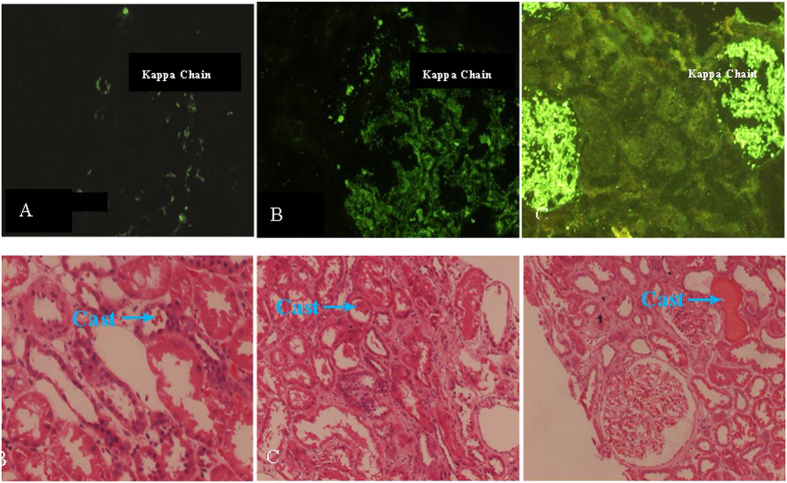
Histopathological findings in MM-RI patients (40×).(A) Mild; (B) Moderate; and (C) Marked lesion.